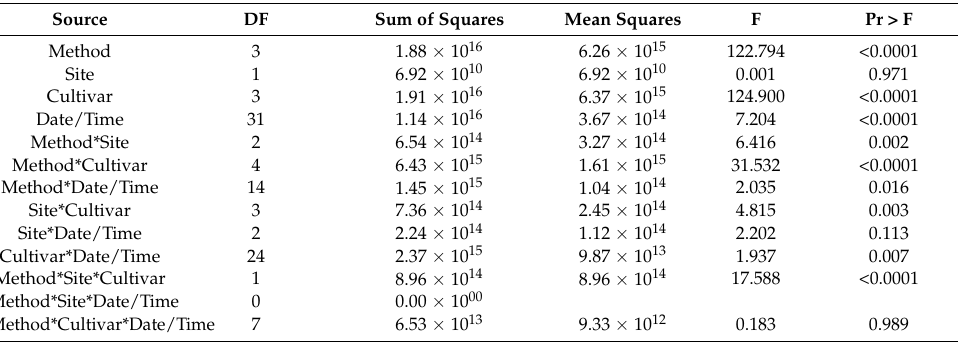
Table A1. Type I sum of squares analyses.